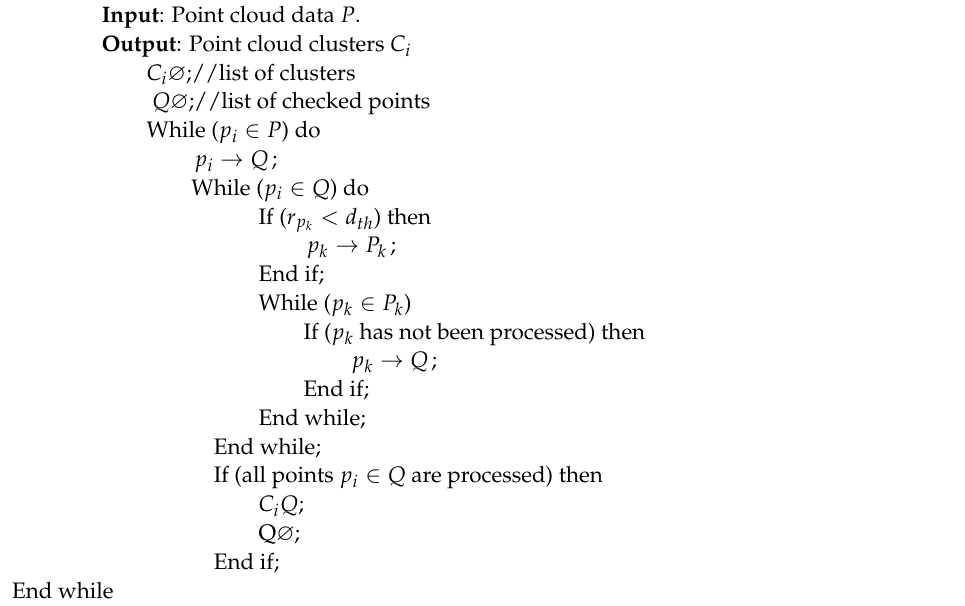
Algorithm 2 Euclidean cluster extraction algorithm to extract the workpiece point